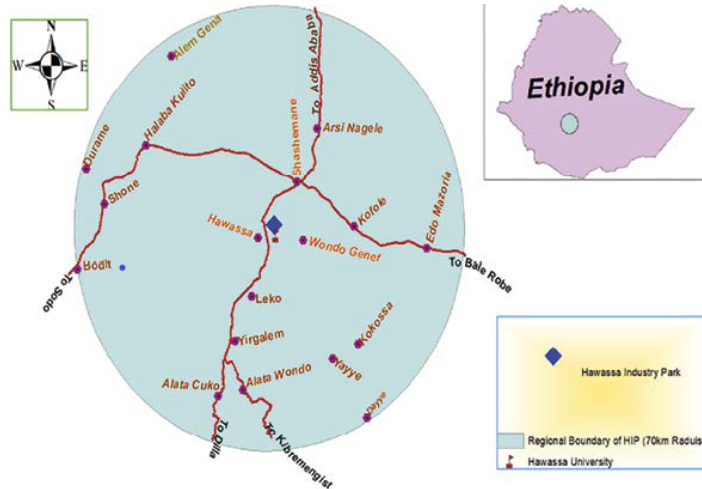
Figure 2. Location map of